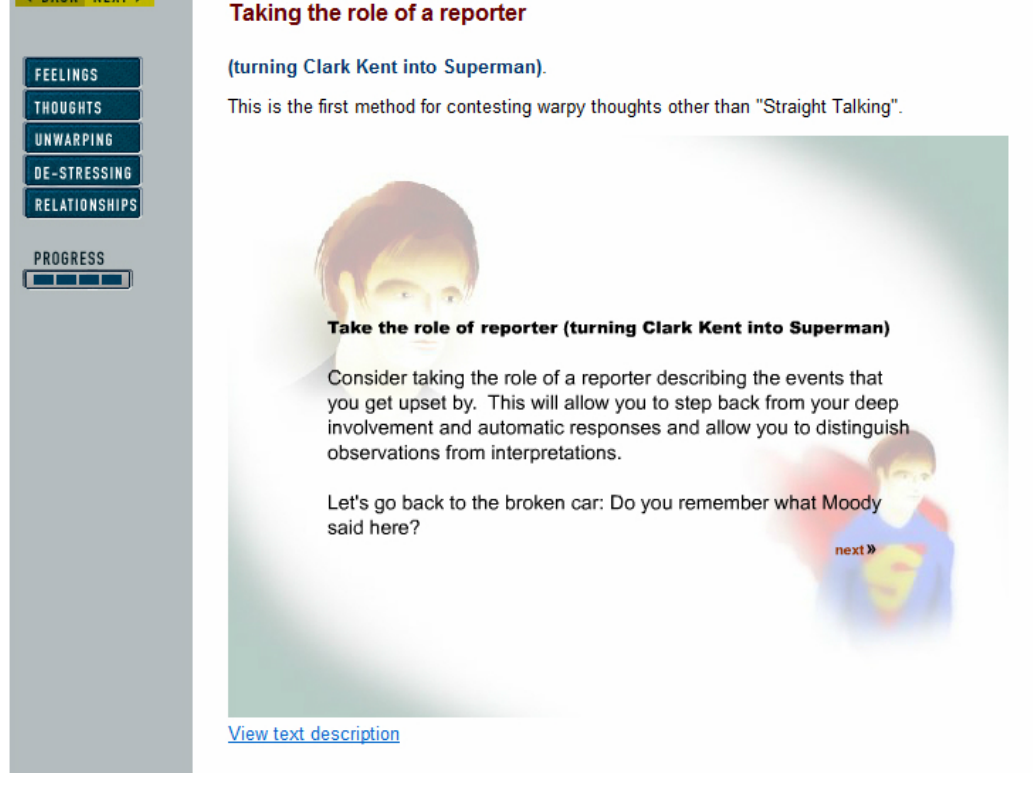
Figure 2. Screenshot from module 3 in